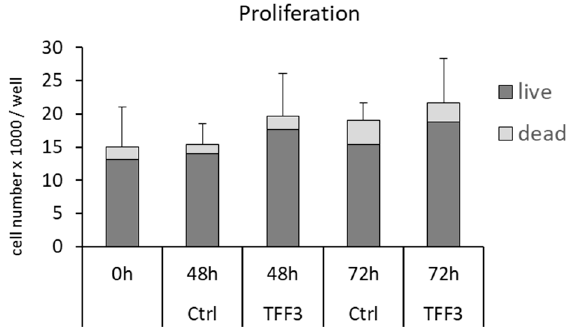
Figure 4. Influence of TFF3 on cell proliferation and viability. Neither proliferation nor viability of mesenchymal progenitor cells (MPCs) is influenced by 10 µg/mL rhTFF3. Bars show the mean ± SD.